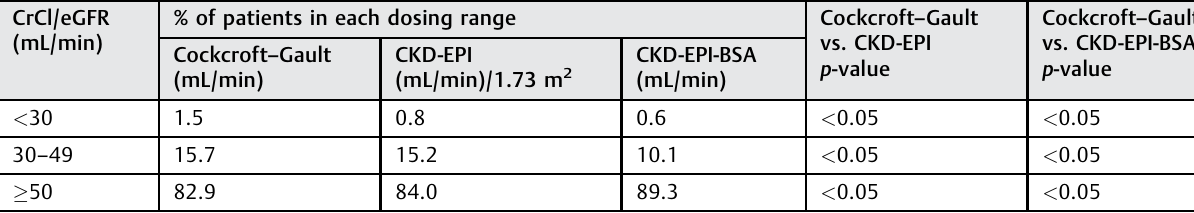
Table 3 Percent dosing discordance for CKD-EPI and CKD-EPI-BSA vs. Cockcroft – Gault for dabigatran etexilate by age category Age category n